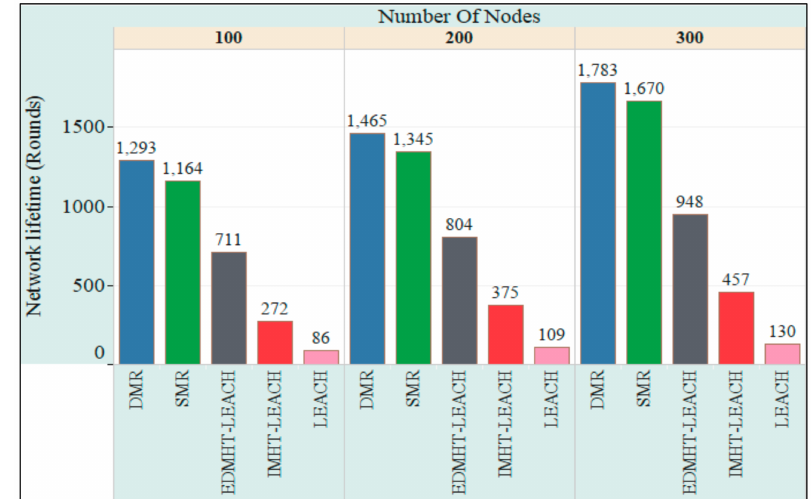
Figure 10. The comparison of the network lifetime versus the number of nodes in the DMR, SMR, EDMHT-LEACH, IMHT-LEACH and conventional LEACH approaches.